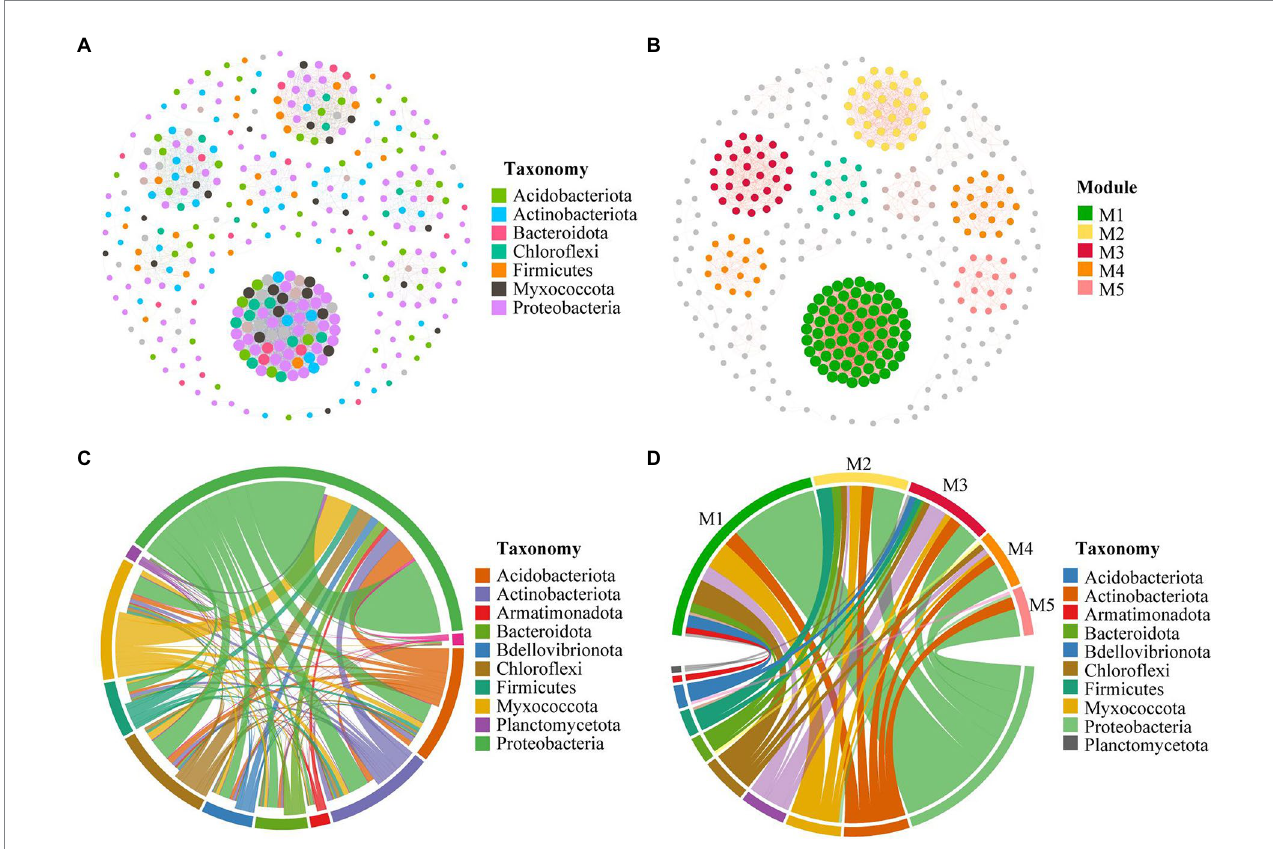
FIGURE 4 Co-occurrence network pattern. (A) Co-occurrence networks of endophytic bacteria communities in G. elata tuber; Phyla of the network as shown in different colors. (B) Co-occurrence networks of endophytic bacteria communities in G. elata ; Modules of the network as shown in different colors. (C) Co-occurrence relationships within endophytic bacteria communities in G. elata tuber; phyla as shown in different colors. (D) Co-occurrence relationships between phyla and